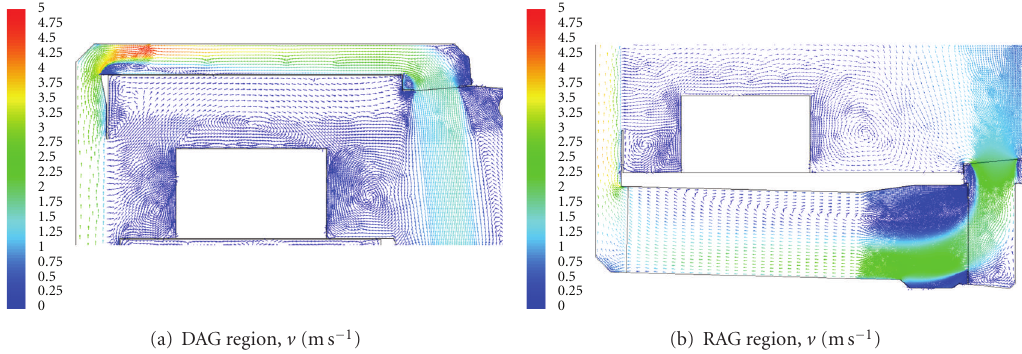
Figure 8: Velocity vectors field numerical predictions.